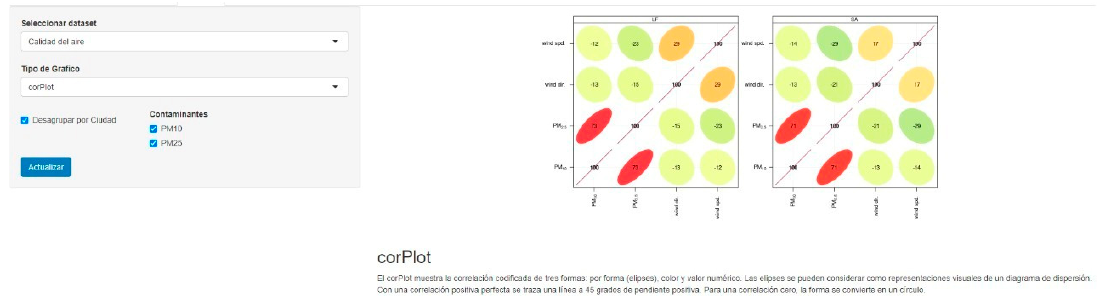
Figure A4. PM10, PM25, wind speed, and wind direction correlation plot for the monitoring stations La Florida (LF) and Parque O’Higgins